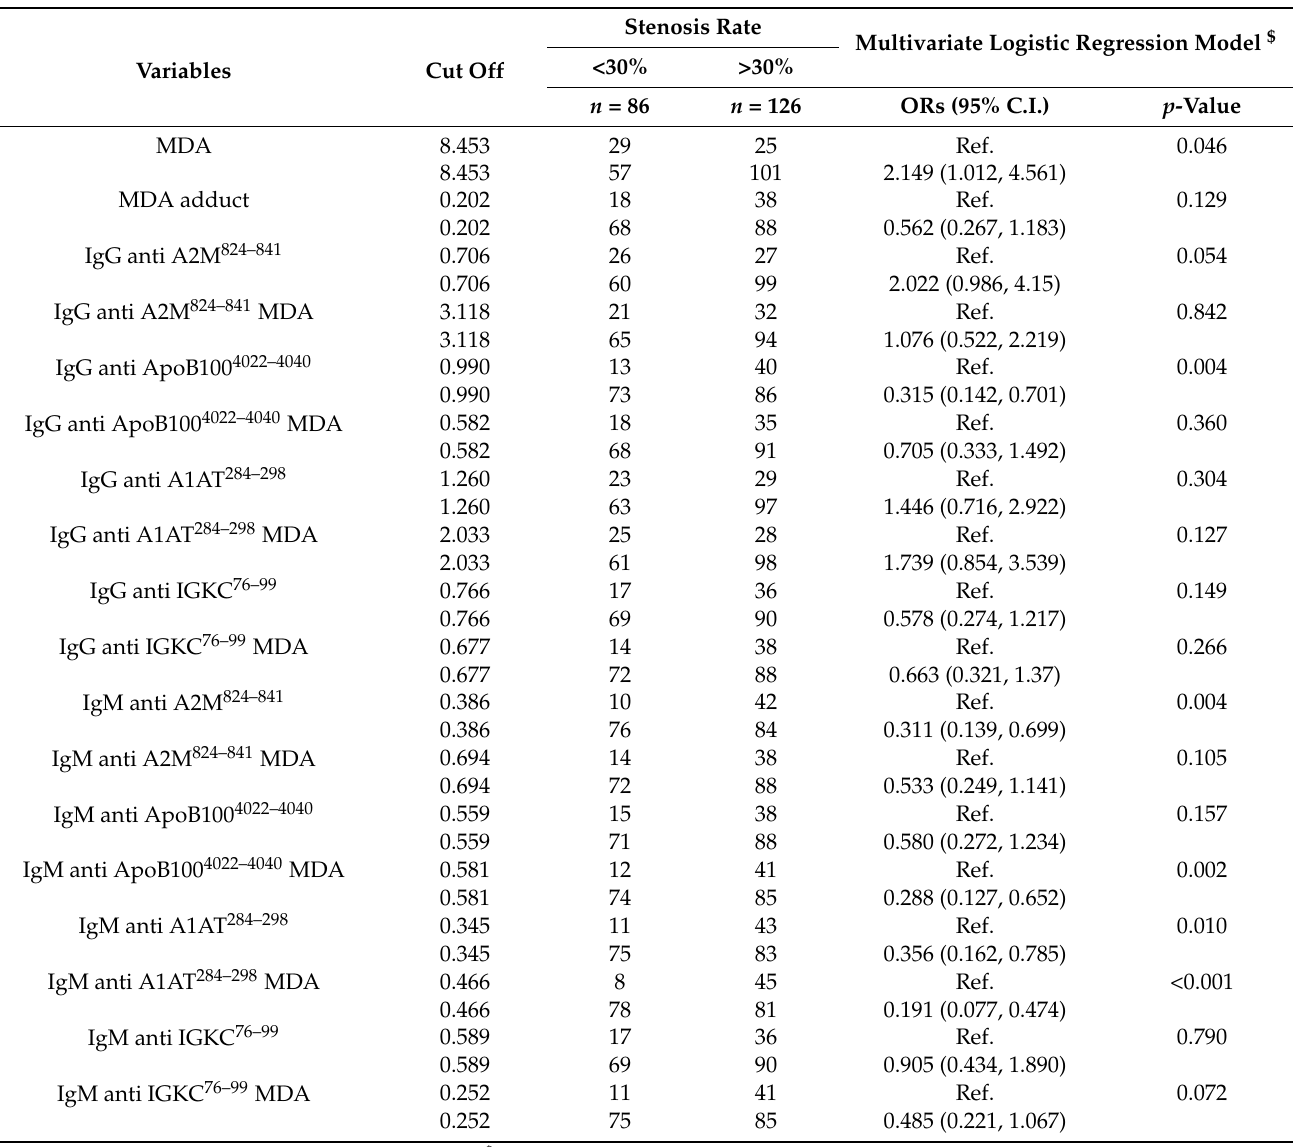
Table 2. Association of malondialdehyde (MDA) protein adducts and autoantibody isotypes against unmodified and MDA-modified peptides in coronary artery disease patients with a stenosis rate of >30% compared to patients with a stenosis rate of